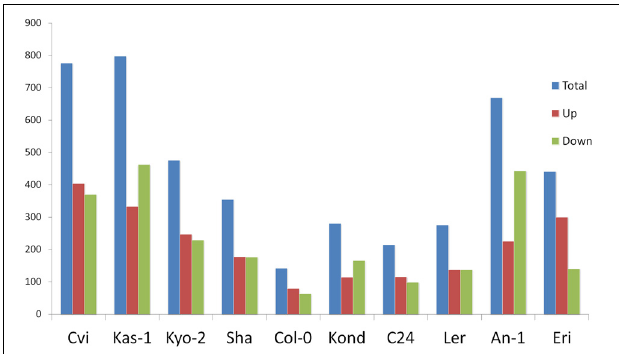
FIGURE 1 | Numbers of differentially regulated transcripts in each of the 10 ecotypes at significance level p ≤ 0 . 01. Ecotypes are on the x axis and numbers of differentially regulated transcripts on the y axis. Blue bar represents total number of differentially regulated transcripts, red bar the number of positively regulated (up) transcripts and green bar represents number of negatively regulated (down) transcripts.